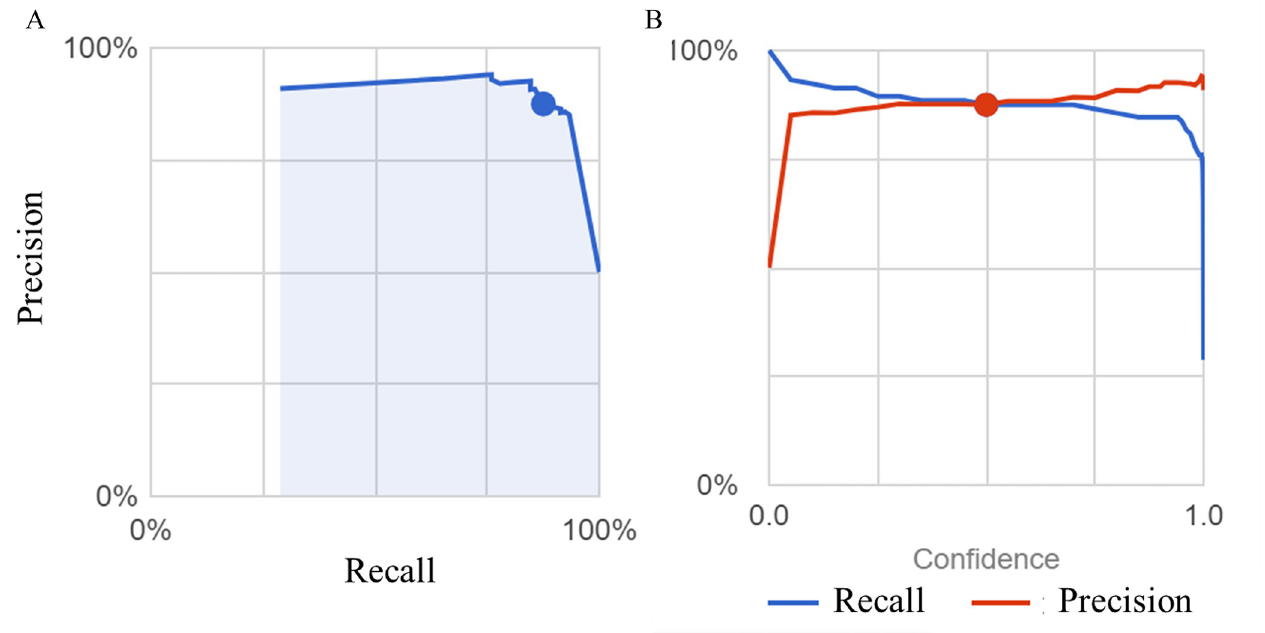
Fig 5. (A) The precision of the Groups C and D colon image AI model is plotted as a function of recall. The blue shaded area represents the area under the curve (AUC), and the blue dot indicates the value in the case with a reliability threshold of 0.5. (B) The intersection of the recall (blue line) and the precision (red line) is shown. The blue and red dots indicate the values when the reliability threshold is set to 0.5.